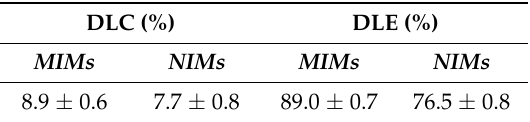
Table 3. Drug loading content (DLC) and drug loading efficiency (DLE).